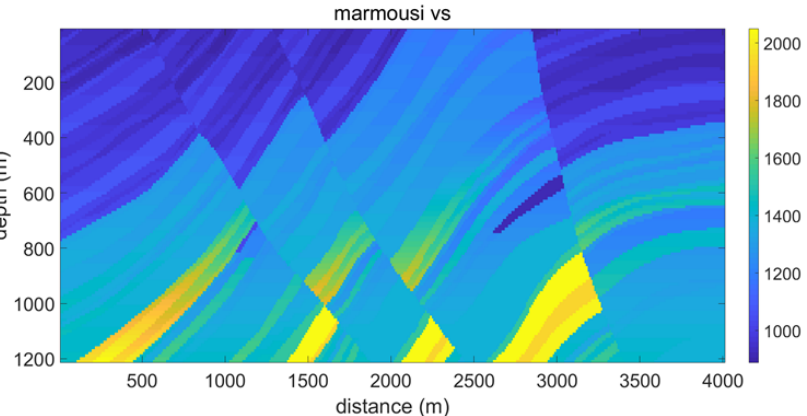
Figure 9. Marmousi model: shear ‐ wave velocity model.